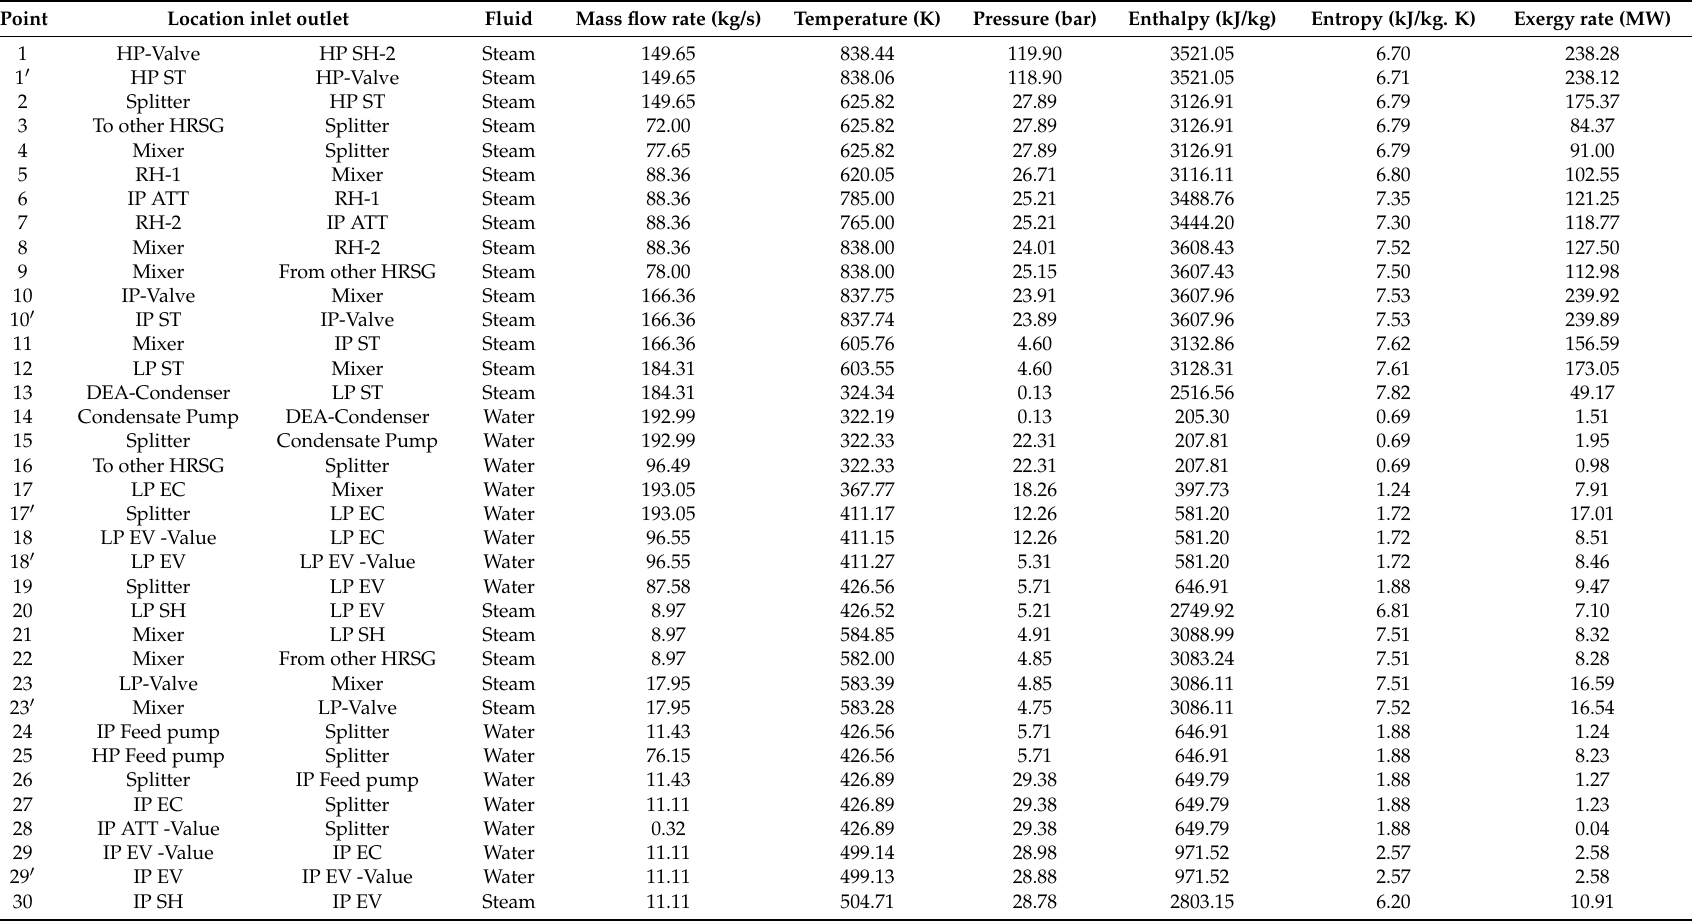
Table B1. Exergetic data for the bottoming cycle at ISO